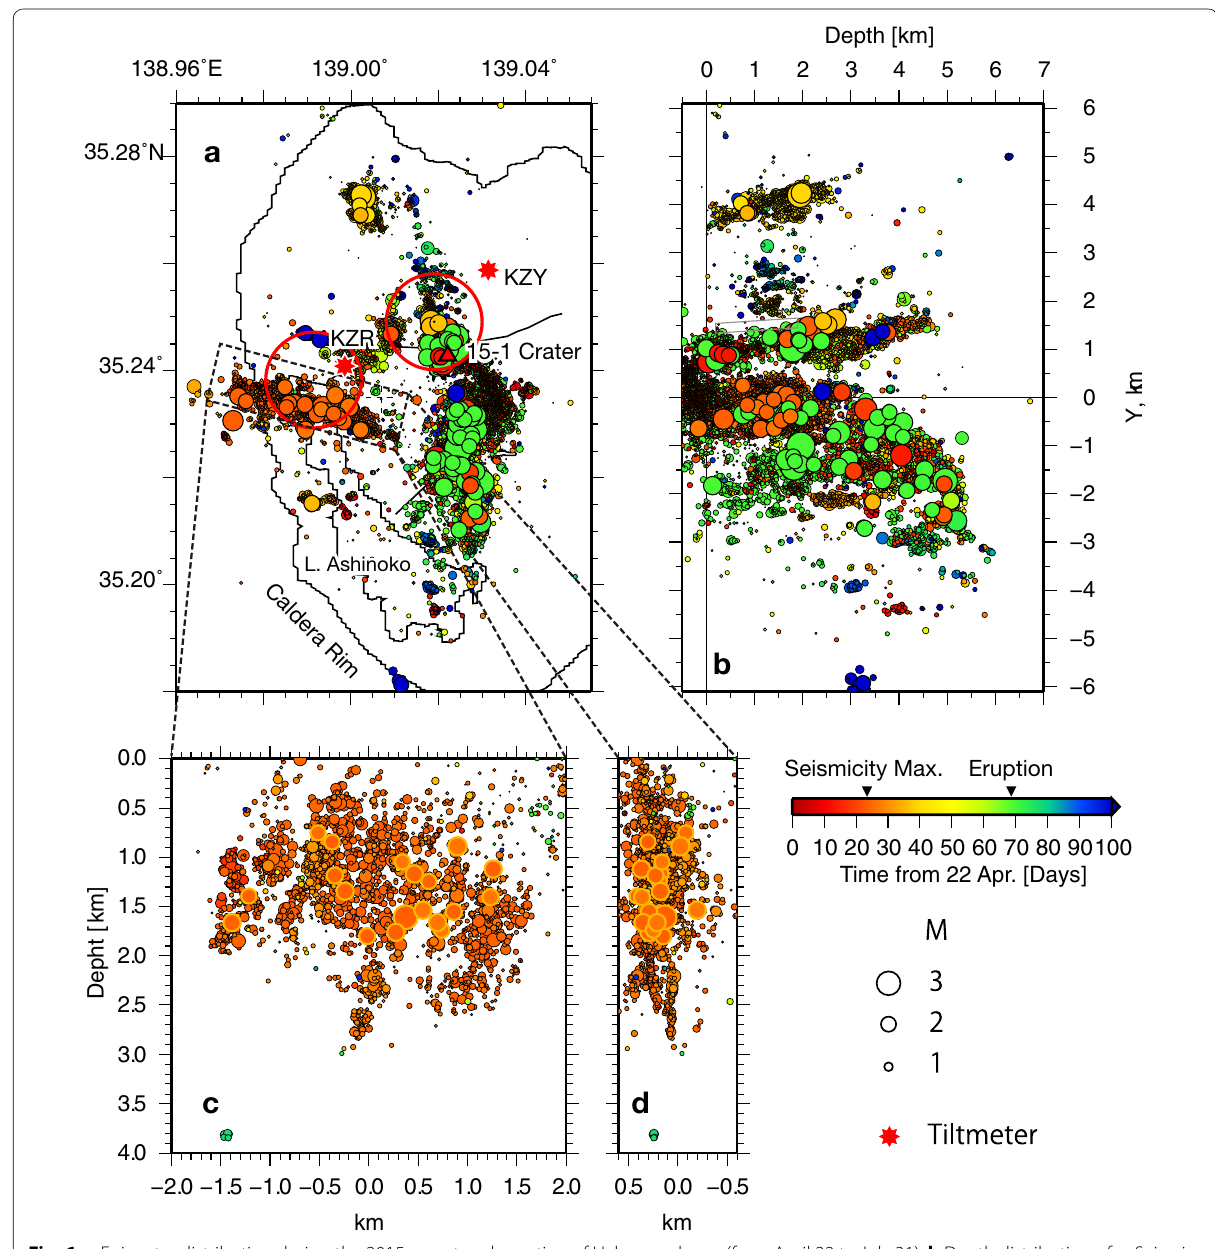
Fig. 6 a Epicenter distribution during the 2015 unrest and eruption of Hakone volcano (from April 22 to July 31). b Depth distribution of a . Seismic- ity seems to concentrate along planes likely formed by open cracks; an example in the Kojiri area is shown by depth distributions along strike ( c ) and dip ( d ) directions. Temporal seismicity change within the red circles during the unrest is shown in Fig.